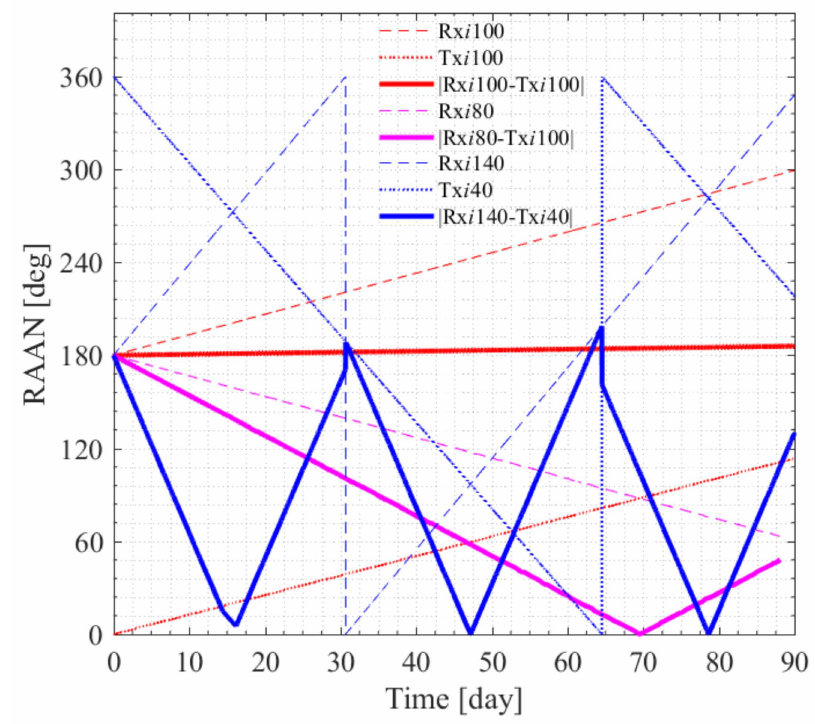
Figure 7. Rx and Tx RAANs and their absolute differences for Rxi100 (red dashed line), Txi100 (red dotted line), |Rxi100-Txi100| (red bold line), Rxi80 (magenta dashed line), |Rxi80-Txi100| (magenta bold line), Rxi140 (blue dashed line), Txi40 (blue dotted line), and |Rxi140-Txi40| (blue bold